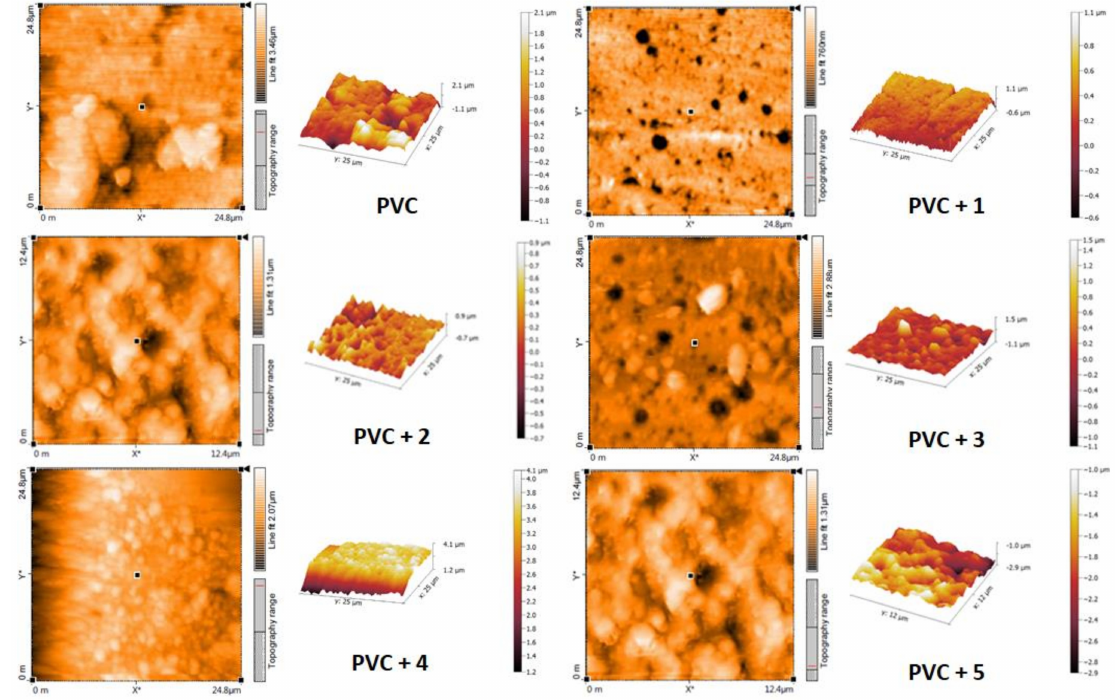
Figure 12. Atomic force microscopy (AFM) images of PVC after irradiation.